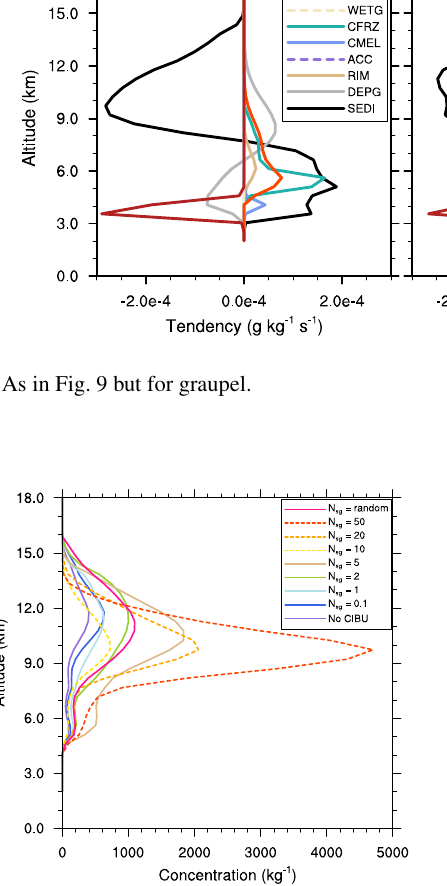
Figure 12. Mean profiles of the cloud ice crystal concentrations N i (gkg − 1 ) of the STERAO simulations corresponding to different values of N sg (see the legend for details). The profiles drawn with a dashed line have been divided by 10 to fit into the